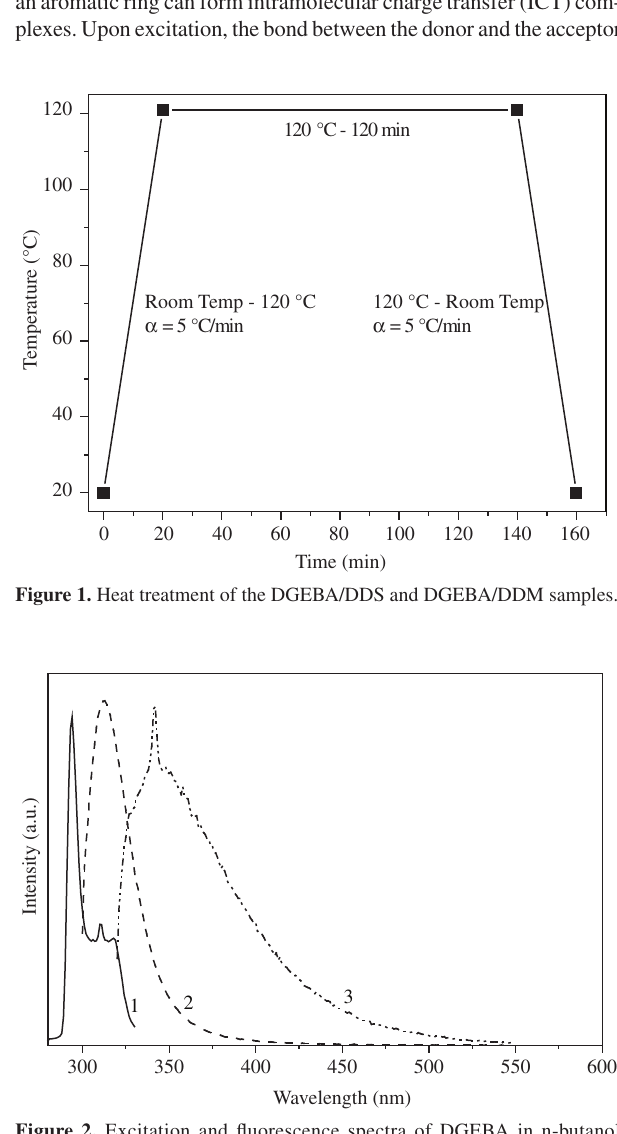
Figure 2. Excitation and fluorescence spectra of DGEBA in n-butanol (1 x 10 -2 mol/L): 1) excitation monitored at 345 nm and fluorescence excited at 2) 290 nm and (3) 310